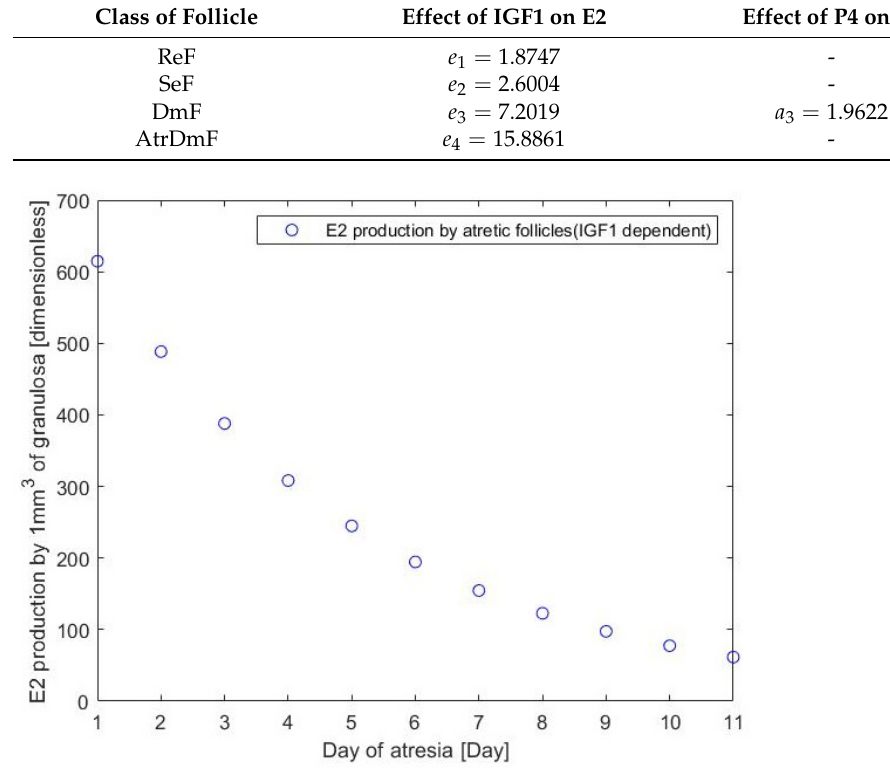
Figure 12. Production rates of E2 by atretic follicles (due to the e 4 term in Equation (1)).